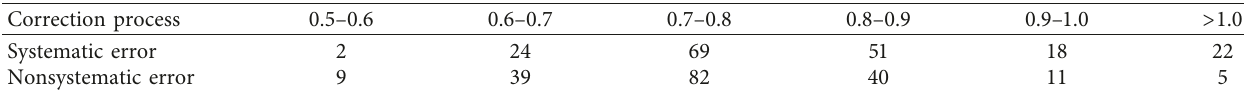
Table 6: Ratio distribution of RMSE of 48h forecast of geopotential height on 500hPa between corrected forecast and the forecast of model. Correction